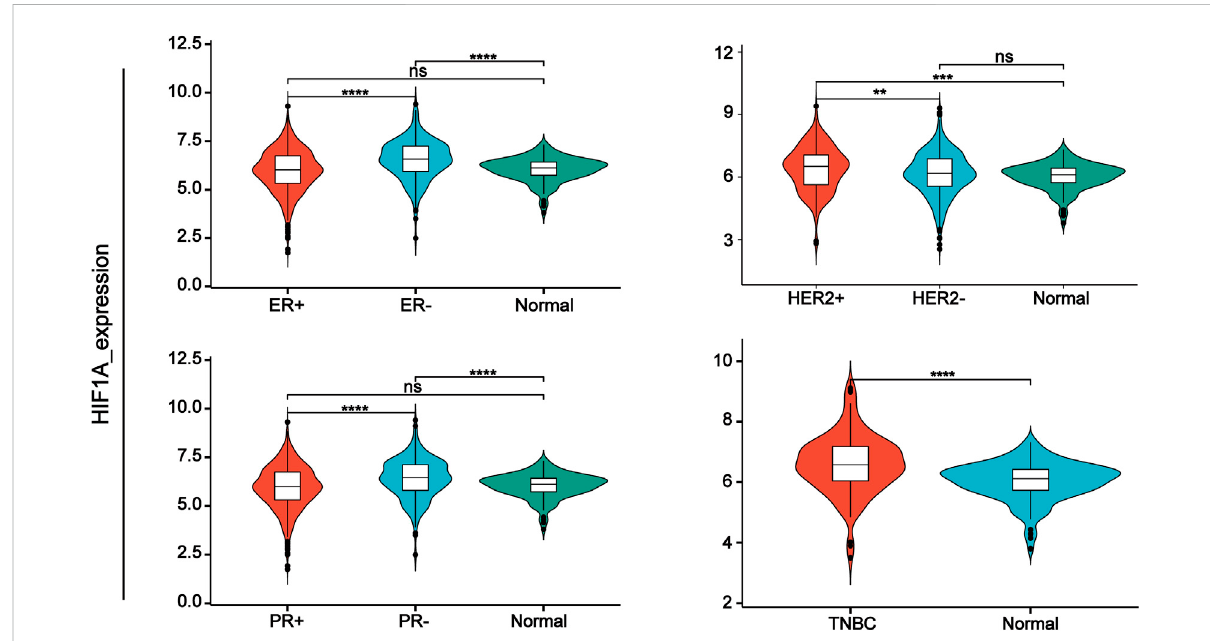
FIGURE 1 HIF-1 α expression in different types of breast cancer tissue samples compared with normal tissue from TCGA